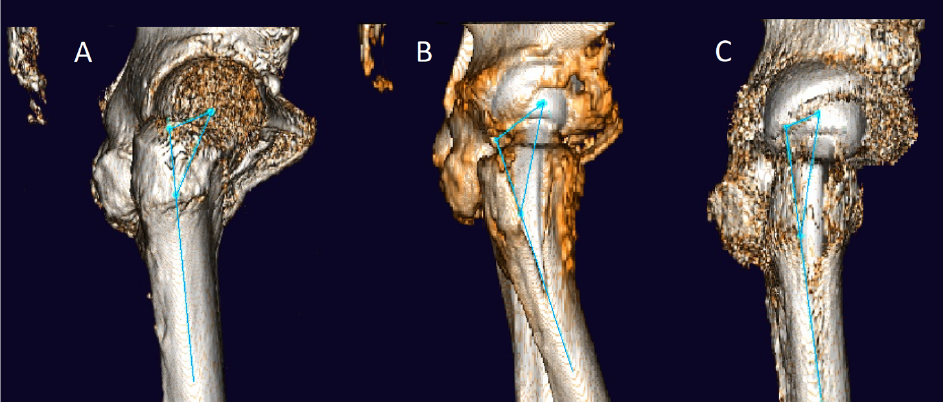
Figure 1. Preoperative and postoperative CT measurement method. 3D measurements obtained with mediCAD hip 3D software, showing the proximal femoral long axis defined by two points and the femoral anteversion angle formed between a perpendicular line through the proximal femoral long axis and the femoral head, and a line connecting the femoral condyles. ( A ): preoperative condition. ( B ): postoperative condition with short stem. ( C ): postoperative condition with straight stem. 3D measurements with mediCAD hip 3D. The femoral long axis is defined by two points in the proximal femur: (1) inferior border of the lesser trochanter; (2) at a point approxi- mately 6 cm distal in the femoral shaft. The angle between the perpendicular line